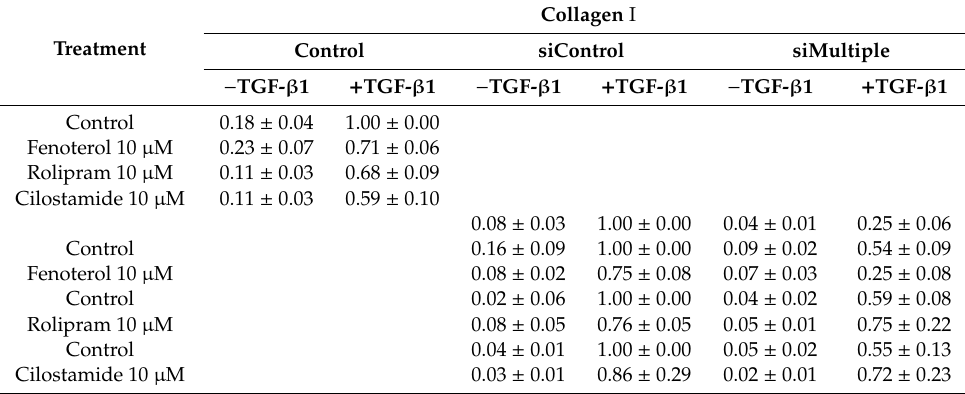
Figure 12. Combined Ezrin, AKAP95 and Yotiao silencing differentially blunted reduction of TGF- β 1-induced collagen Ӏ elevation by fenoterol, rolipram and cilostamide in BEAS-2B cells. ( A – C ) Representative western blotting images and quantification of collagen Ӏ in cells pre-incubated with fenoterol ( A ) rolipram ( B ) or cilostamide ( C ) before TGF- β 1 treatment. Data represent four independent experiments. The data are expressed as mean ± SEM, * p < 0.05; significantly different between indicated groups. # p < 0.05; significant difference compared to control groups. Table 4. The comparison of Collagen Ӏ protein expression in co-silencing multiple AKAPs with or without cyclic adenosine monophosphate (cAMP) donors.